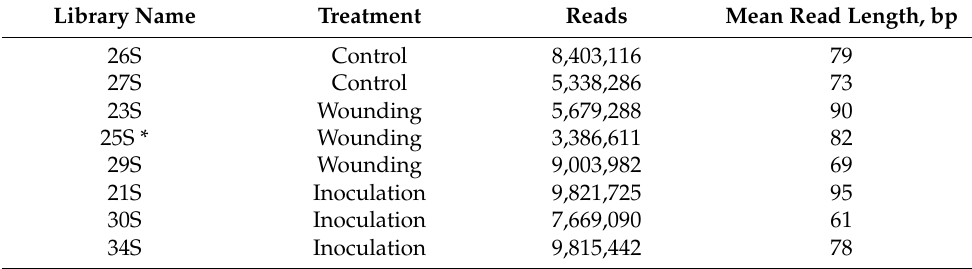
Table 1. Read count and read length of transcriptome sequencing